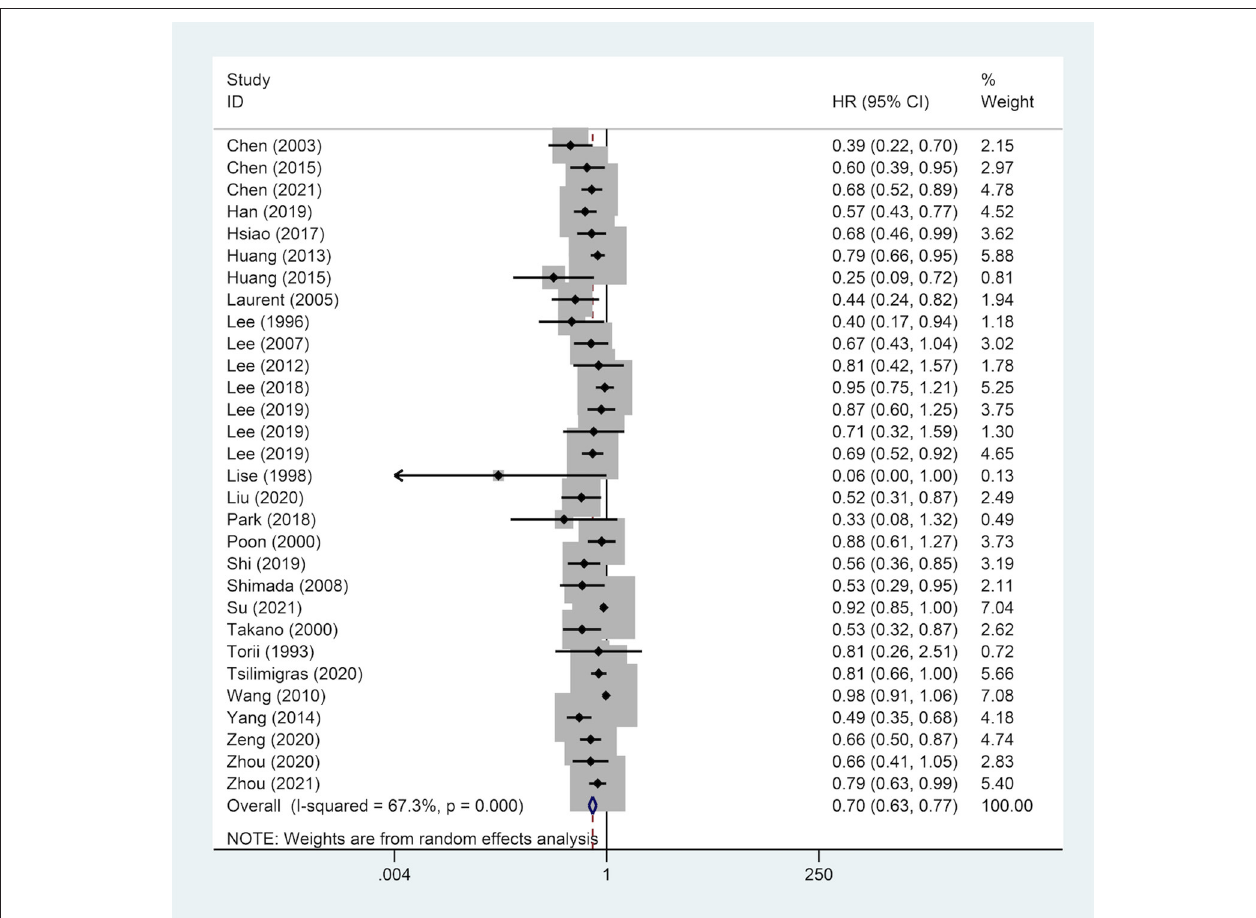
FIGURE 2 | Forest plot of OS of HCC patients receiving wide surgical margin.